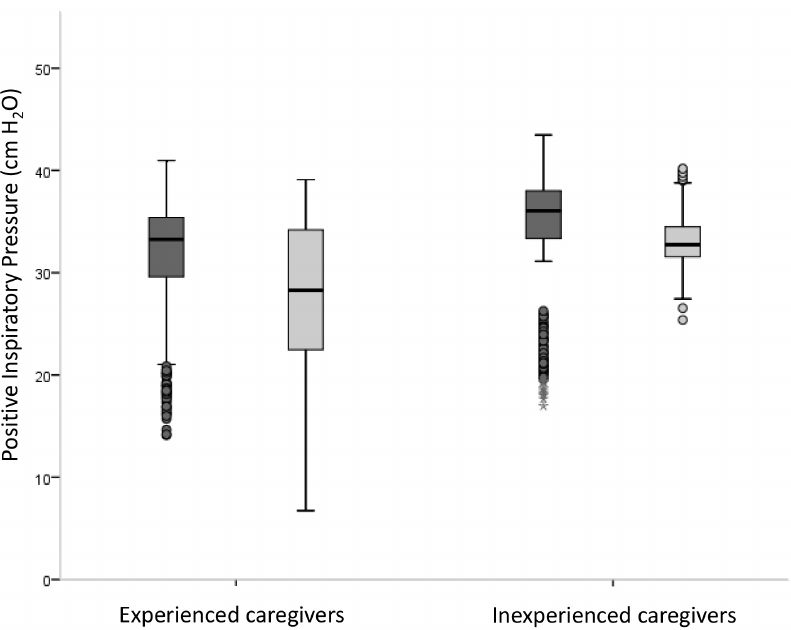
Figure 2. Median (IQR) pressures (cm H 2 O) given of experienced and inexperienced caregivers before (dark grey) and after (light grey) two-minute training using self-inflating bag (SIB). The box plots show median values (solid black bars), IQR (margins of box), and range of data.